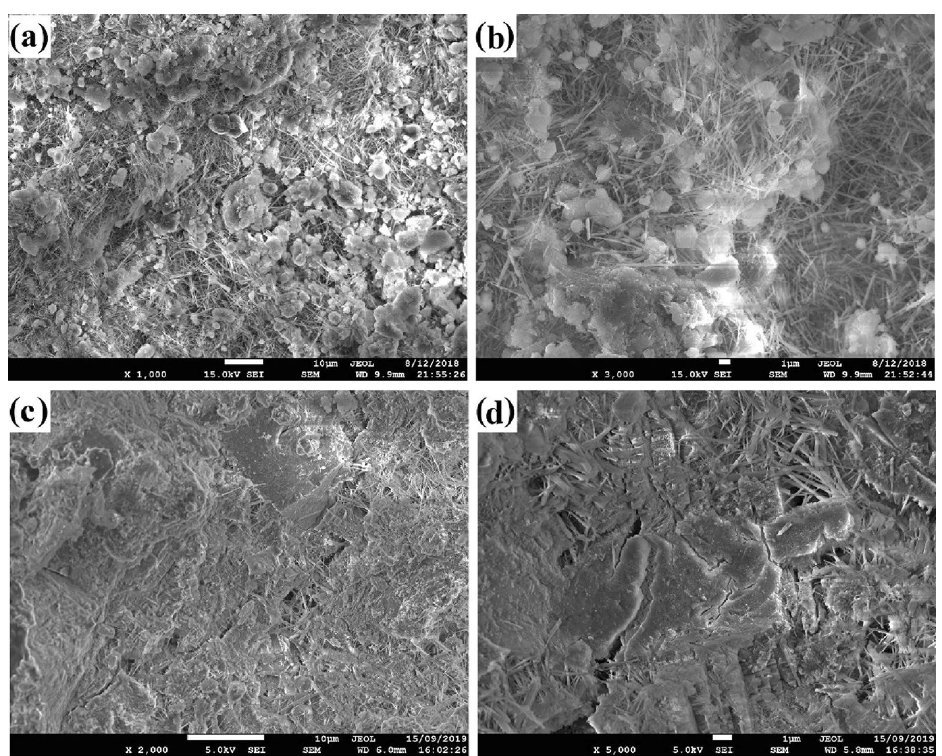
Figure 6. SEM micrographs from fracture surfaces of the ( a , b ) neat cement and ( c , d ) BN–F5 sample hydrated for 28